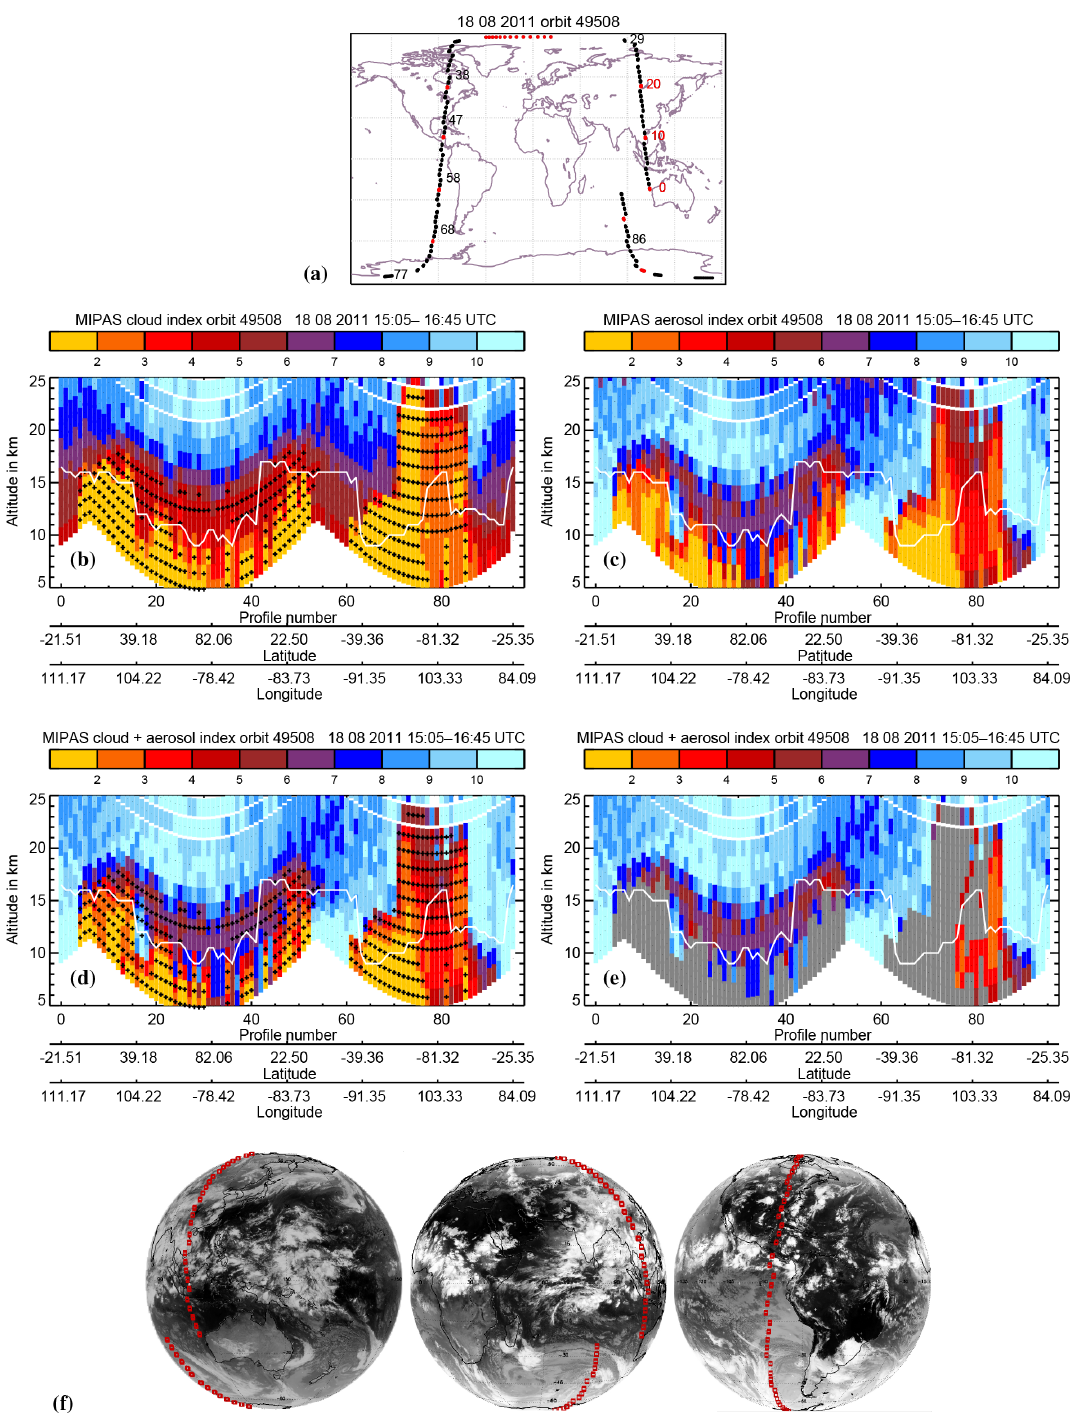
Figure 2. MIPAS profiles of orbit 49508 (a) measured on 18 August 2011 for (b) cloud index, (c) aerosol index, and (d) aerosol–cloud index, (e) aerosol–cloud index. Black crosses denote cloud/aerosol detections using a fixed CI threshold of 2 below 10km and the variable threshold definition following (Sembhi et al., 2012) above 10km. White curves denote the thermal tropopause according to the World Meteorological Organization (WMO) definition along the orbit track derived from ERA-Interim data (Dee et al., 2011). In polar winter the thermal tropopause is often not present (Zängl and Hoinka, 2001). Ice and optically thick clouds (grey body radiators) are shown in grey. The IR nadir measurements of MTSAT, IODC, and GOES-East (f) are shown temporally closest to the MIPAS measurements. The IR nadir images were obtained from NERC Satellite Receiving Station, Dundee University, Scotland,